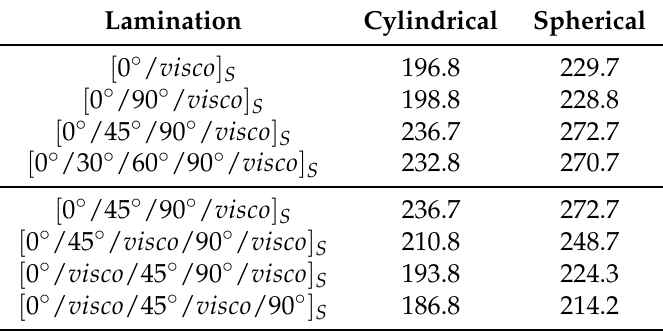
Table 4. Frequency at the first peak (Hz) for the transmitted sound power level ( SPL ) of the composite cylindrical and spherical shells with different lamination